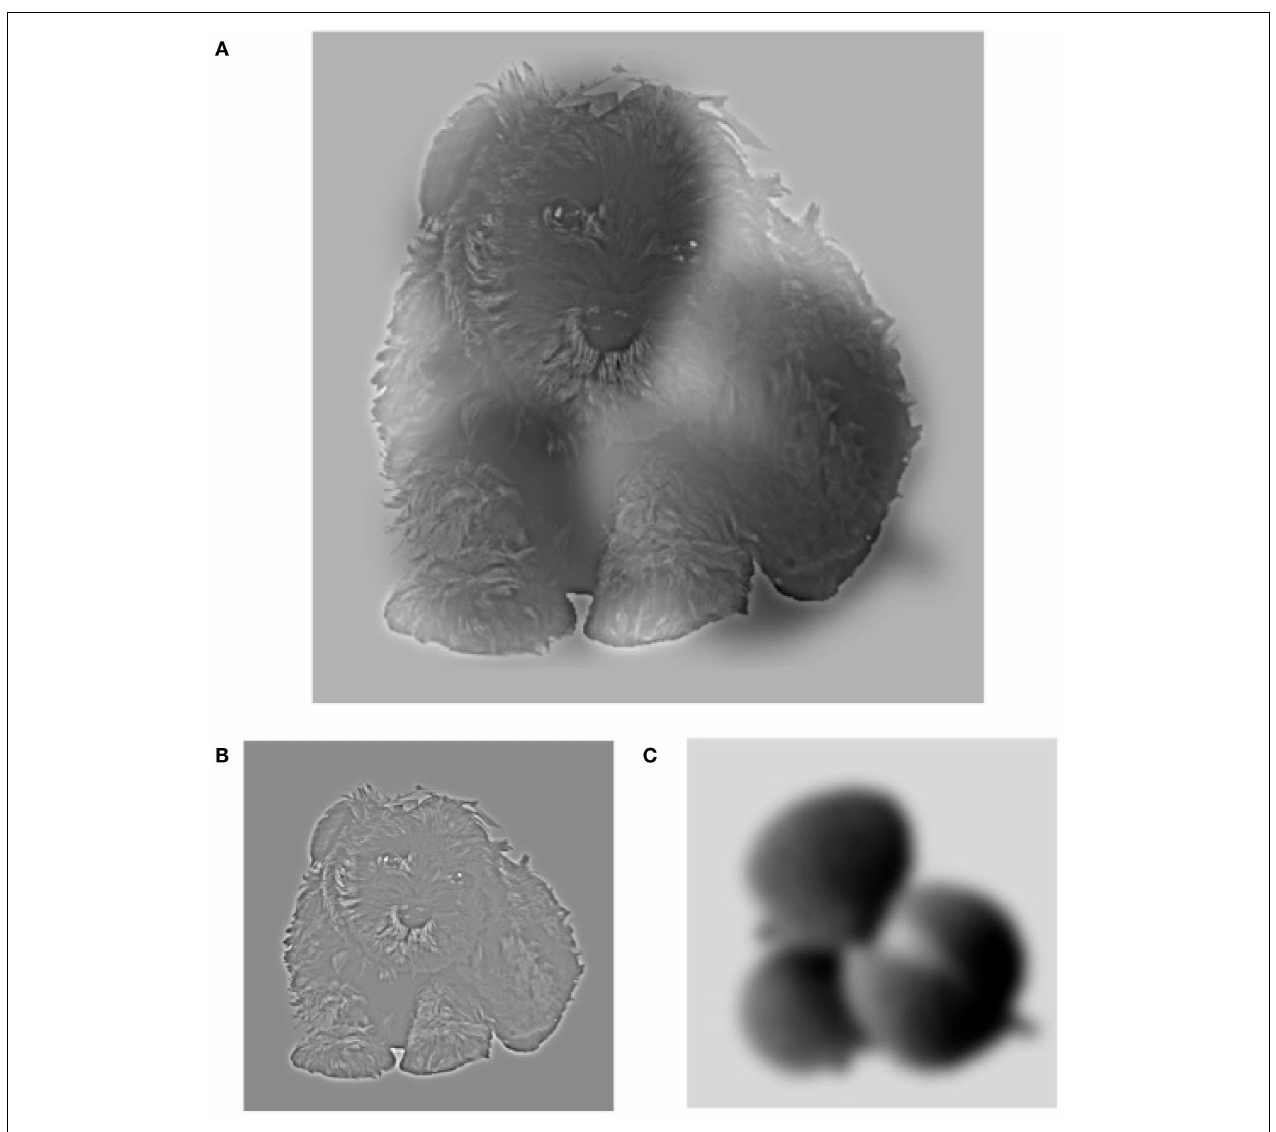
image close to your eyes, and the low spatial frequency information can be better seen if you step away from the image or slightly blur your gaze. Image (B,C) are examples of filtered images that were used in the control